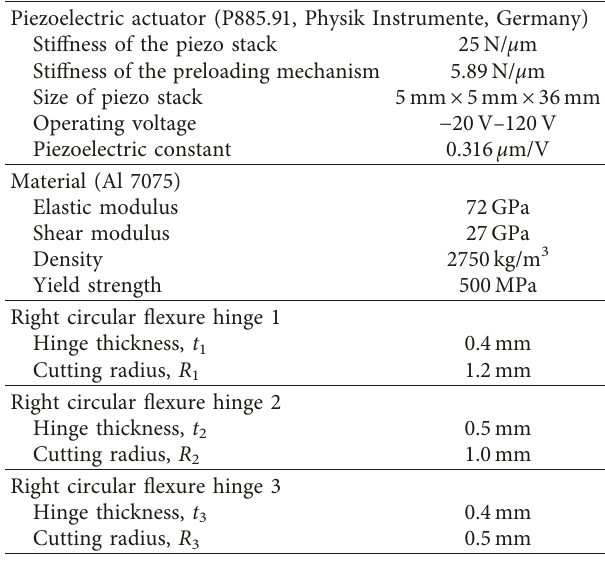
Table 1: Fixed parameters of the